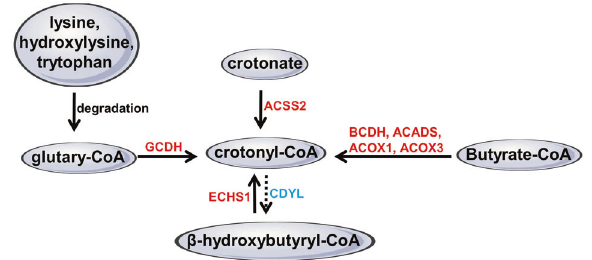
Fig. 2 The generation of crotonyl-CoA. SCFAs such as crotonate can be metabolized to crotonyl-CoA by ACCS2 [15]. Besides, SCFA butyrate could be converted into butyryl-CoA through β -oxidation pathway, and further into crotonyl-CoA by BCDH [17]. ACADS and ACOX3 that catalyze conversion of butyryl-CoA to crotonyl-CoA during fatty acid oxidation were demonstrated to be as key crotonyl- CoA producers during endoderm differentiation [18]. In amino acid metabolism of lysine, hydroxylysine, and tryptophan, GCDH catalyzes the oxidation of glutaryl-CoA to crotonyl-CoA and CO 2 [19, 20]. CDYL converts crotonyl-CoA into β -hydroxybutyryl-CoA